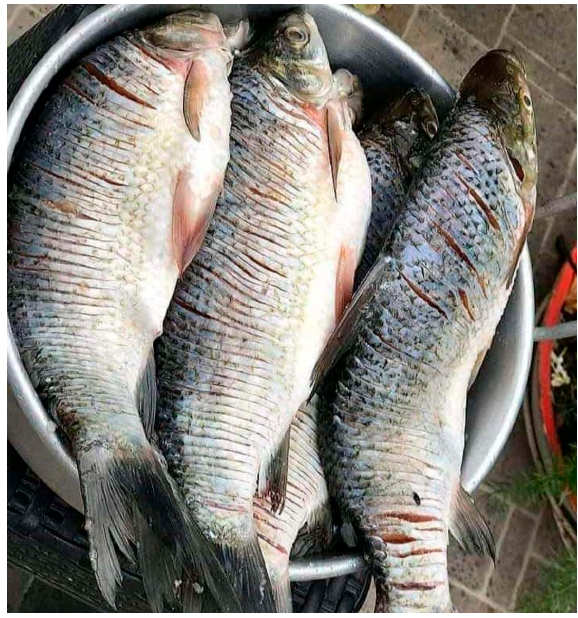
Figure 1. “Bocachico” commercialized informally in the municipality of Plato, Magdalena, Colom- bia.